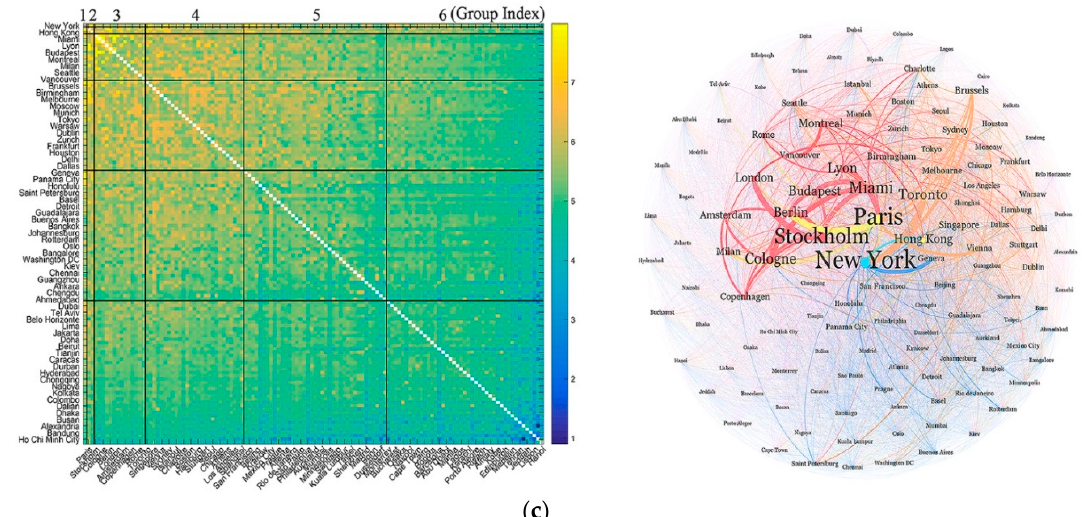
Figure 3. Heatmaps and networked layouts of WCNs in different languages: ( a ) multicores-peripheries structure (English), ( b ) dual-cores-peripheries structure (German), ( c ) a typical core-periphery structure (French).